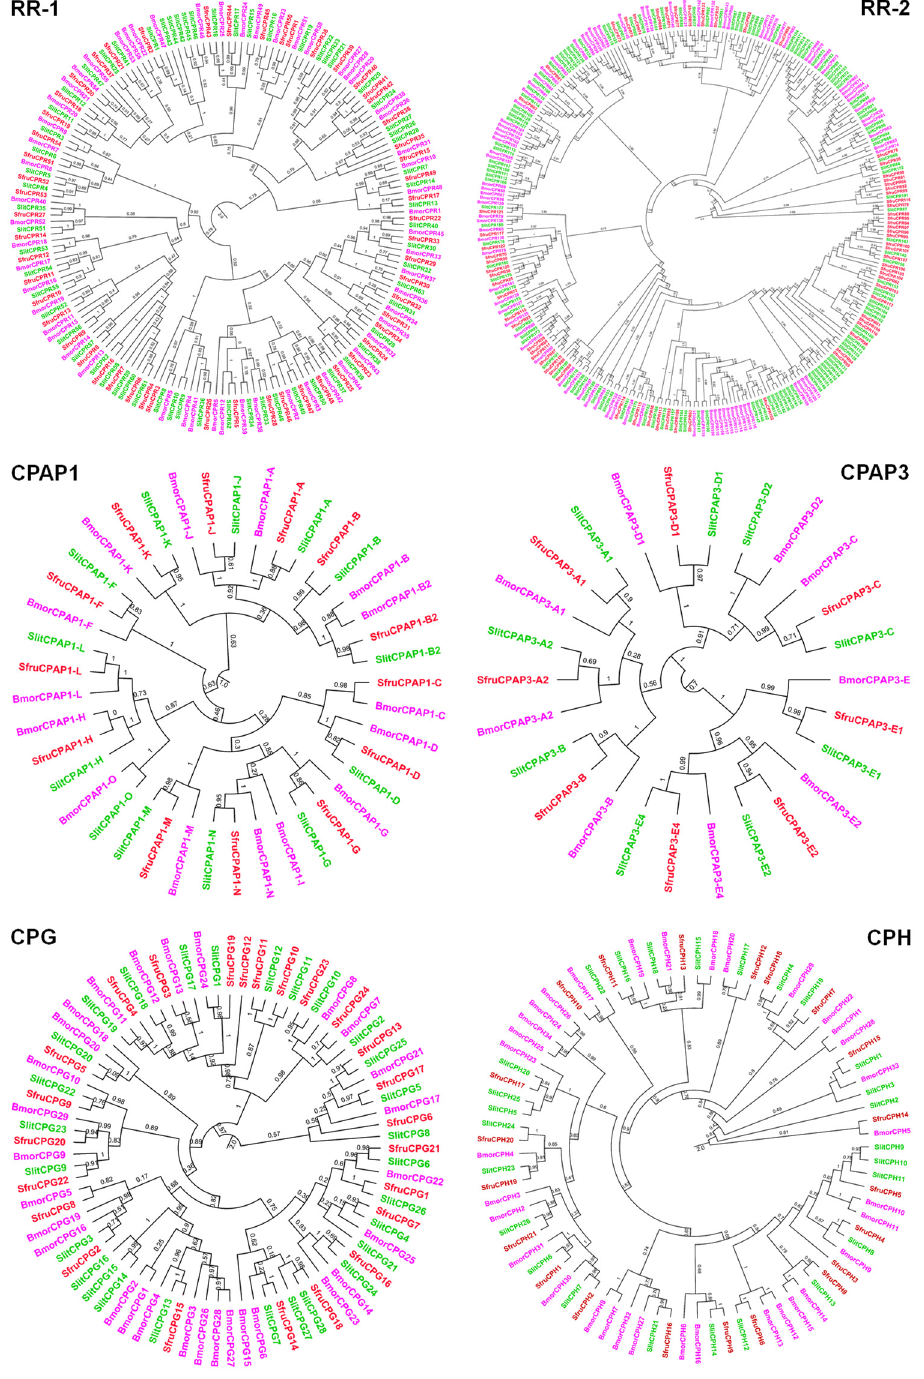
Figure 1. Maximum-likelihood tree of candidate CPs belonging to different families from four lepidopteran species. The tree was constructed by FastTree v2.1.11 (http://microbesonline.org/ fasttree, accessed on 26 July 2021), based on an aligned amino acid sequence with MUSCLE in MEGA X. CPs marked by the same colors represents those from the same species. Bmor, Bombyx mori ; Msex, Manduca sexta ; Sfru, Spodoptera frugiperda ; Slit, Spodoptera litura . Table 1. Summary of the gene number of each cuticular protein family in Spodoptera frugiperda , S. litura , Bombyx mori and Manduca sexta .